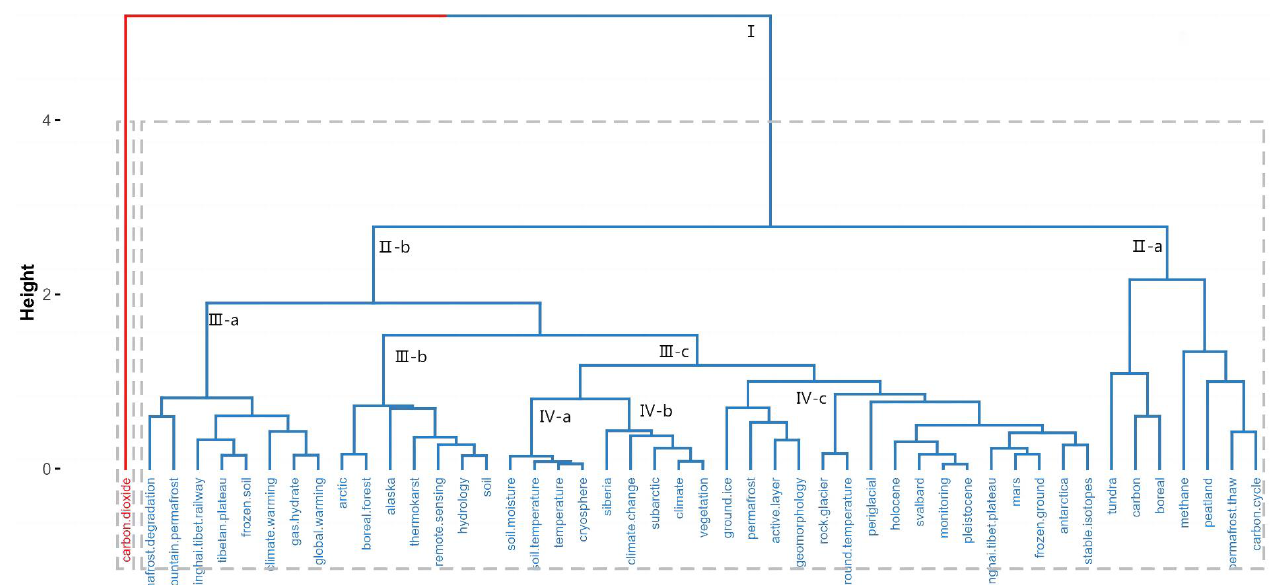
Figure 12. Topic dendrogram of authors’ keywords based on the multiple correspondence analysis method. The cuts and vertical lines in the graph present different clusters. The name of each cluster is marked with a combination of Roman numerals and letters.